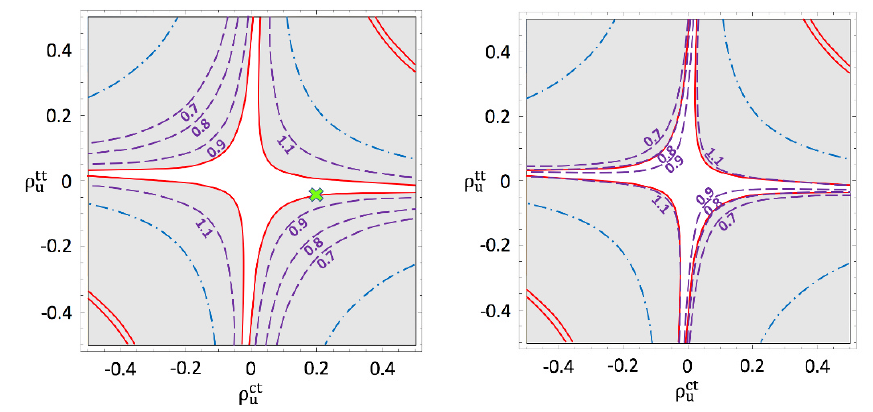
Figure 8 . (cid:26) tt vs. (cid:26) ct in the case (C) with (cid:26) (cid:23) = 1(left) ; 2(right) and ( m A ; m H ; m u u (200 GeV ; 200 GeV ; 200 GeV). The gray region is excluded by the B s (cid:0) B s mixing (solid red lines) and b ! s(cid:13) (dotted-dashed blue lines). The dashed purple lines denote the predictions of R ( K ).